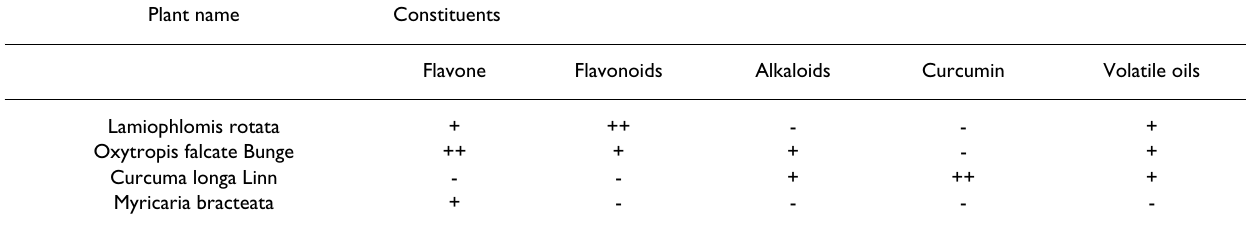
Table 1: HPLC screening of extracts from four plants of PRP Plant